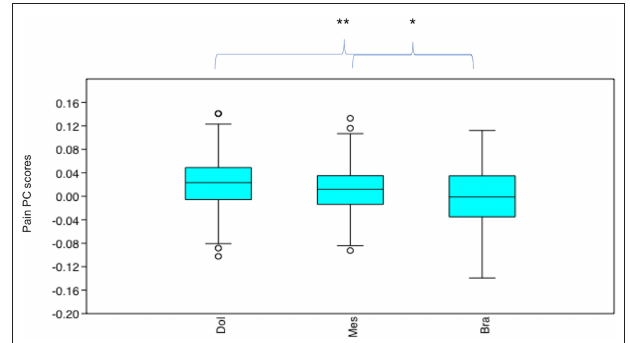
FIGURE 10 | Boxplot with minimum, first quartile, median, third quartile, maximum values and outliers for Pain PC scores for each cephalic type, across 19 breeds ( n = 475). Dol, dolichocephalic; Bra, brachycephalic; Mes, mesocephalic. * p < 0.05, ** p < 0.01. A lower Pain PC is indicative of greater pain-like features